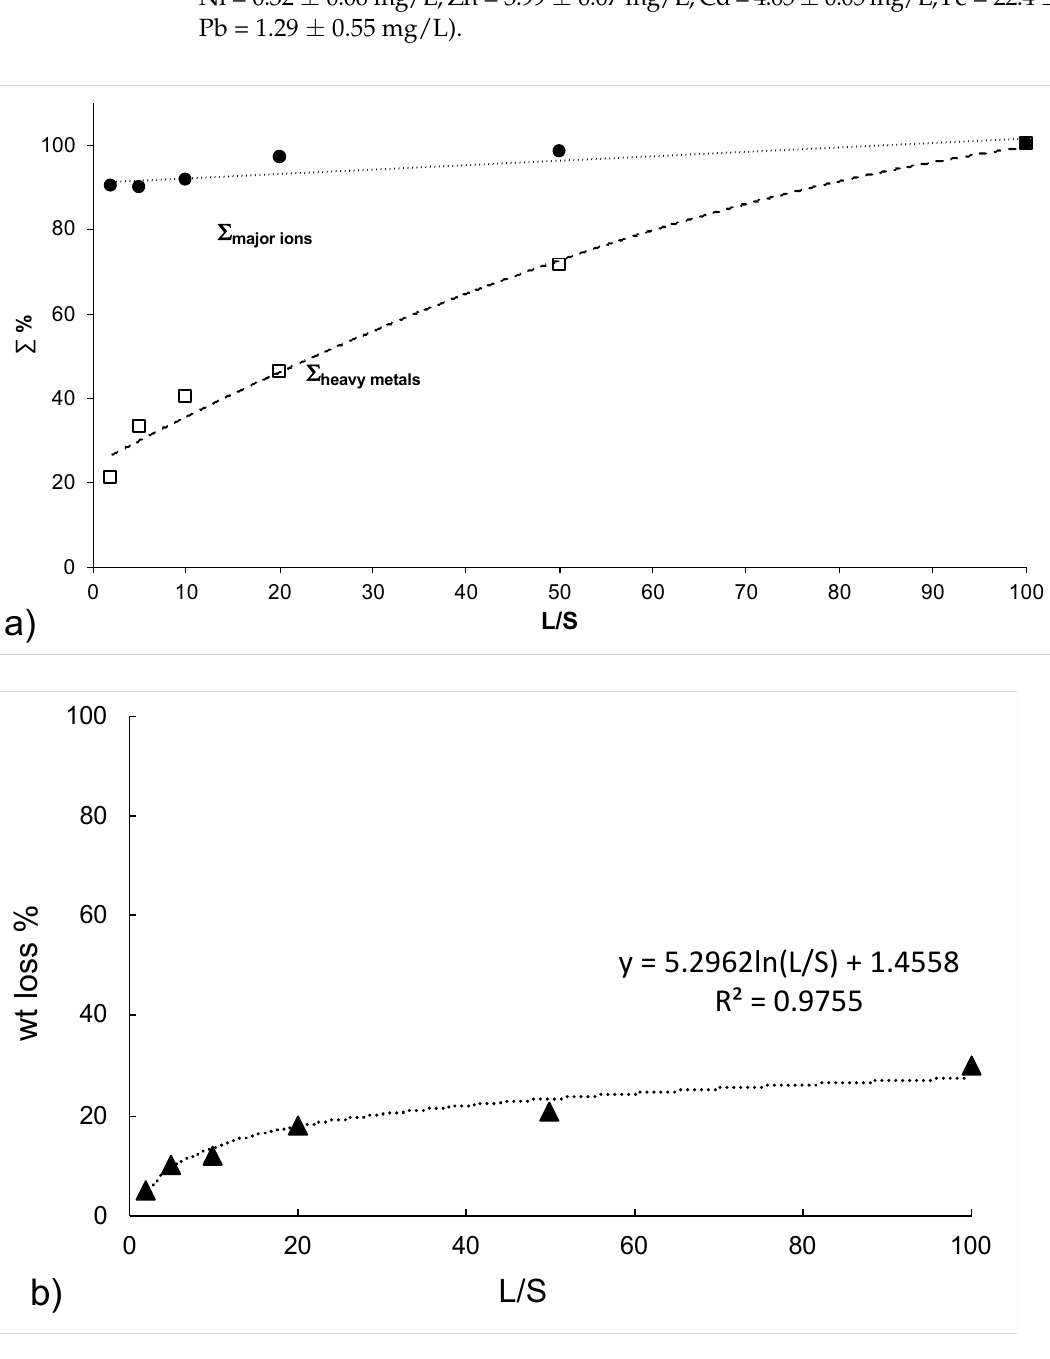
Figure 2. Washing treatments: 24 h duration. ( a ) Σ major ions = Na, K, Ca, Mg, bromide, fluoride, chloride, sulfate, and nitrate (filled circles), and Σ heavy metals = Cr + Ni + Cu + Zn + Cd + Fe + Ba + Pb (empty squares), versus L/S. Figures are normalized to their maximum values in terms of Σ major ions and Σ heavy metals . ( b ) Weight loss (triangles) of MSWI-FA versus L/S because of mineral dissolution due to washing.